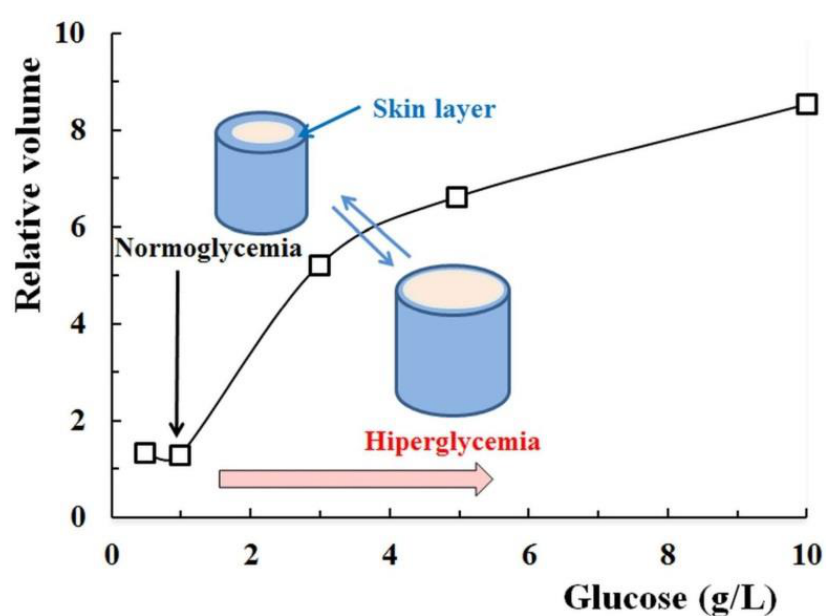
Figure 5. Volume changes of poly(NIPMAAm- co -AAmECFPBA) gel as a function of glucose amount at 37 °C (Adapted with permission from [77]. Copyright © 2023 WILEY-VCH Verlag GmbH & Co. KgaA, Weinheim).